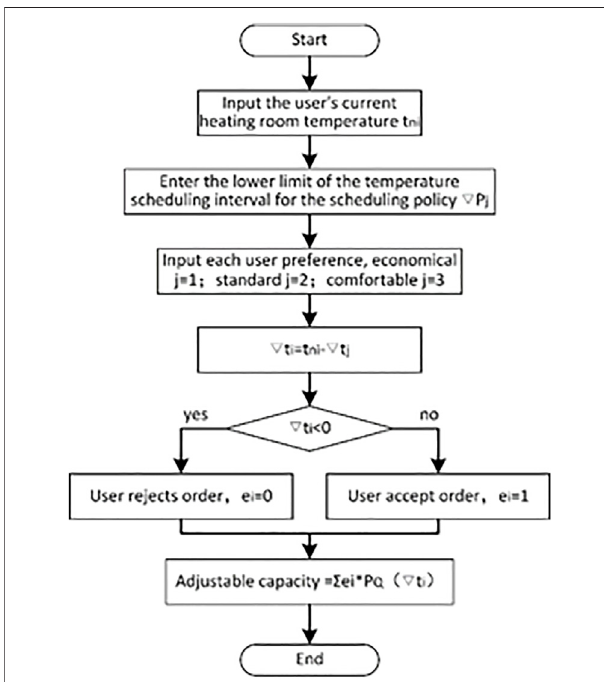
FIGURE 8 | Household electricity heating adjustable power calculation fl ow chart.